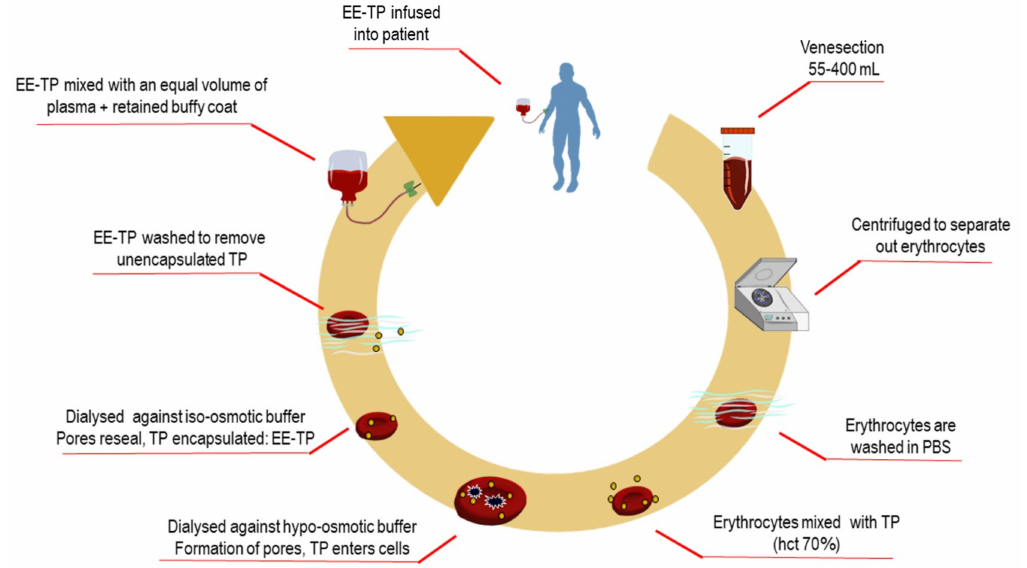
Figure 2. Manufacture of erythrocyte-encapsulated thymidine phosphorylase (EE-TP).